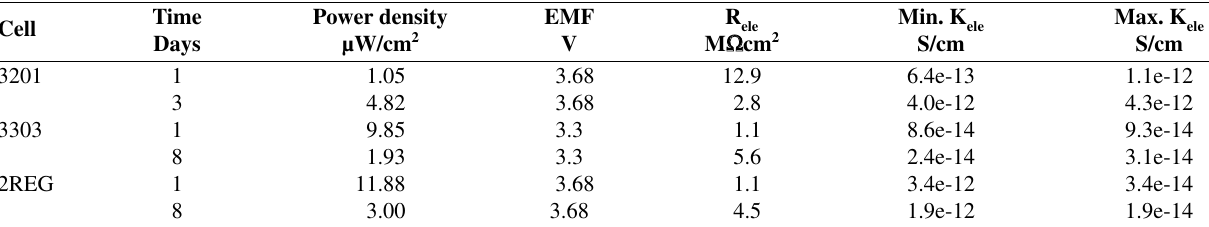
Table 8. Microcalorimetry result and the derived electronic conductivities. K and max K is found from C ele